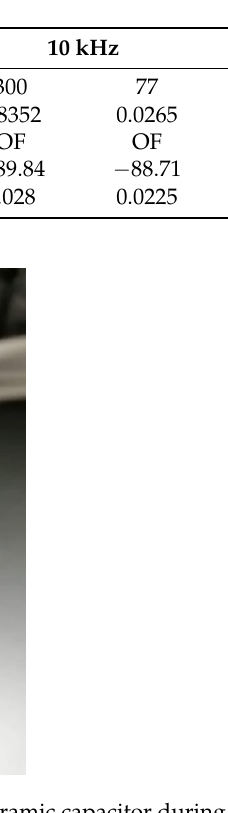
Table 5. The ceramic capacitor test results.